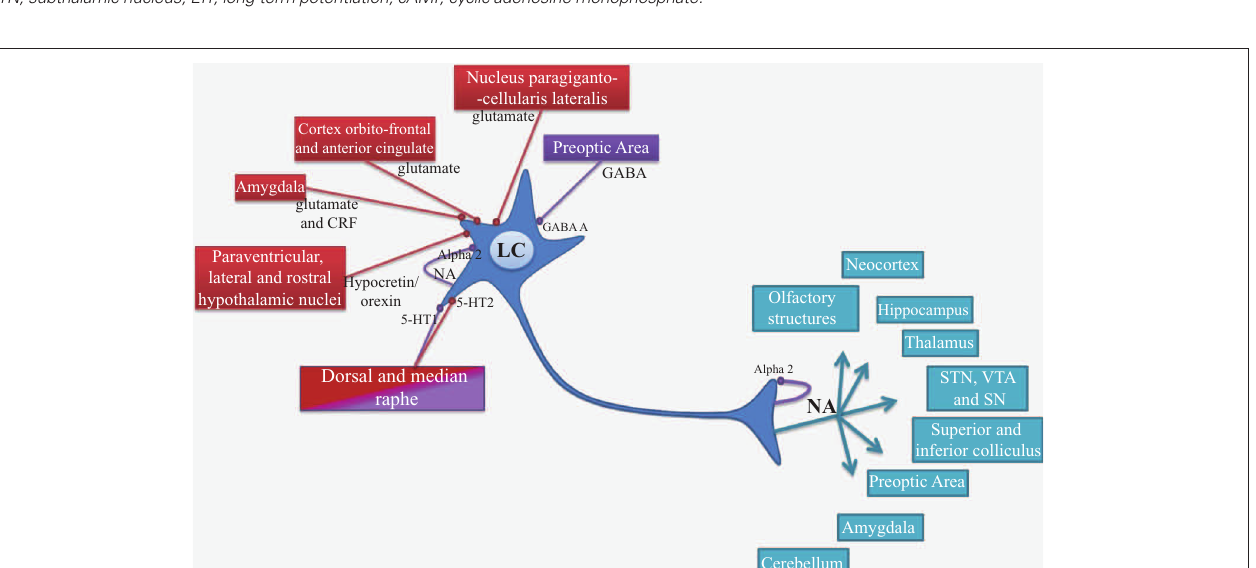
Figure 1 | Afferent (red and purple) and efferent projections of LC neurons (blue). LC, locus coeruleus; NA, noradrenaline; Alpha2, Alpha2 receptor; GABA, γ -aminobutyrique acid; GABA A, GABA A receptor; 5-HT, serotonin; 5-HT1 and